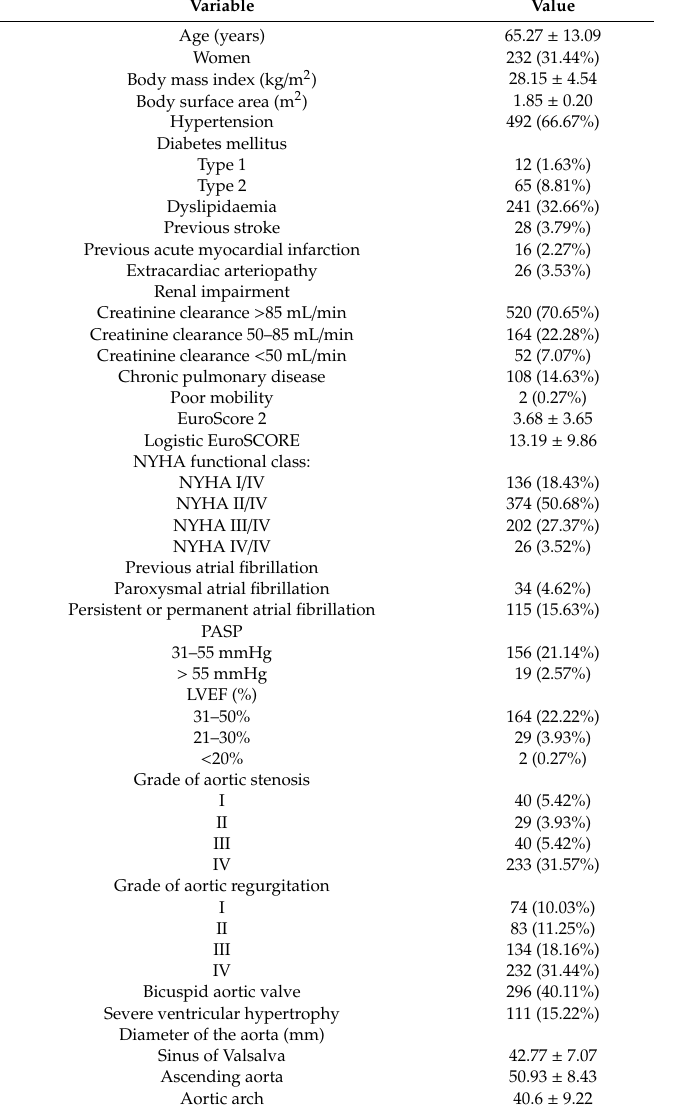
Table 1. Patients characteristics.